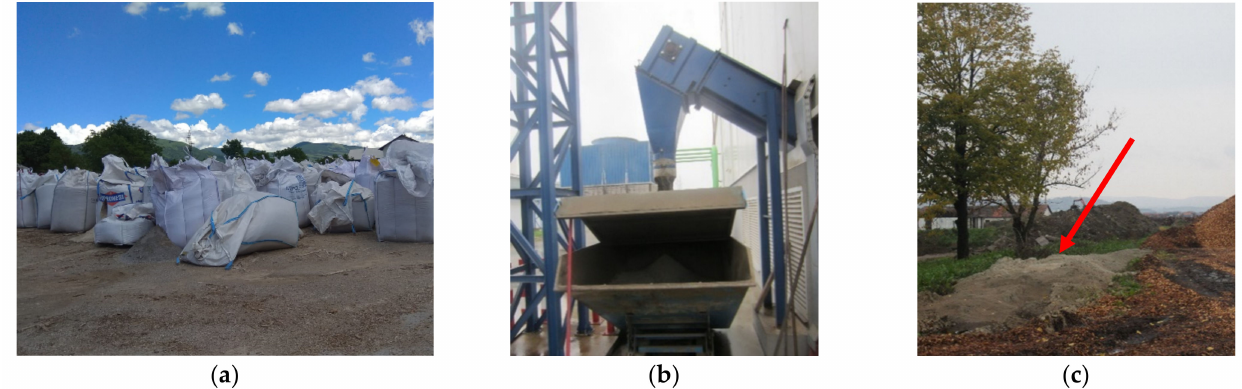
Figure 1. Different approaches to wood biomass ash (WBA) storage: ( a ) in plastic bags; ( b ) in the container; ( c )